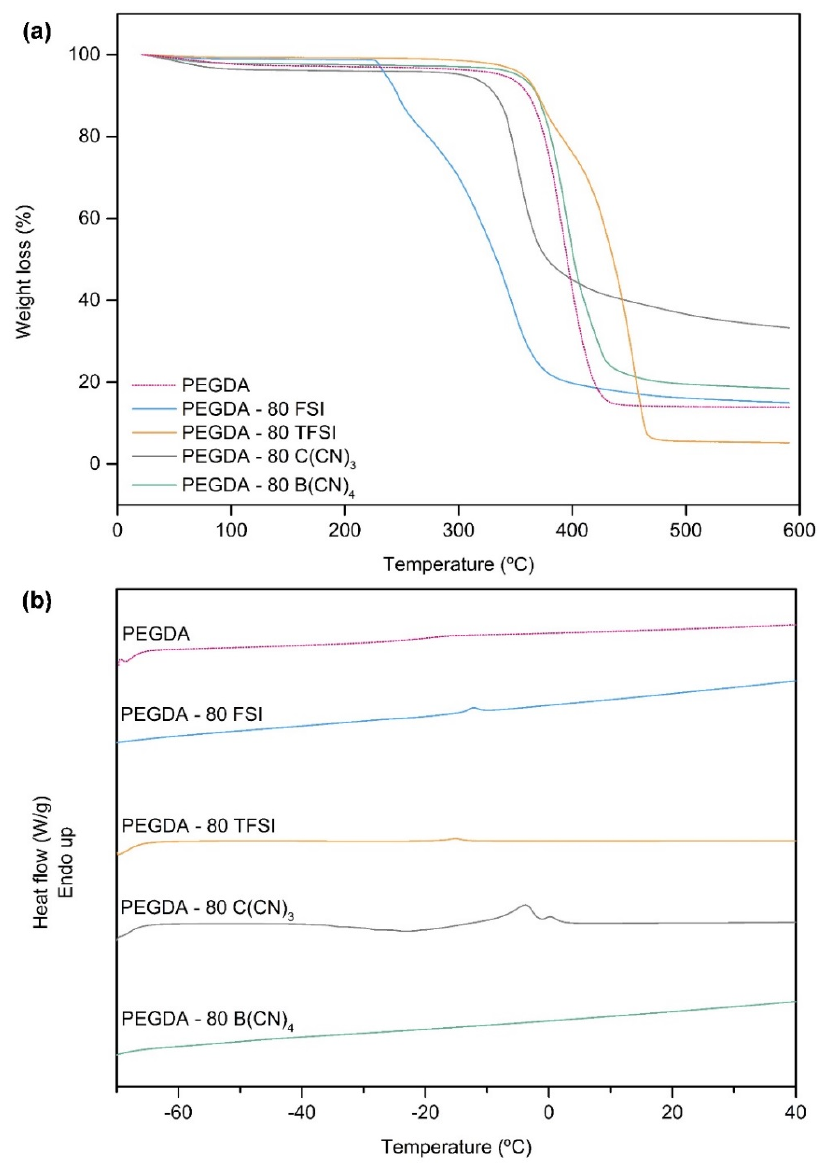
Figure 4. ( a ) Thermogravimetric analysis (TGA) thermograms and ( b ) differential scanning calorimetry (DSC) curves of the iongels (80 wt % IL) bearing different anions.